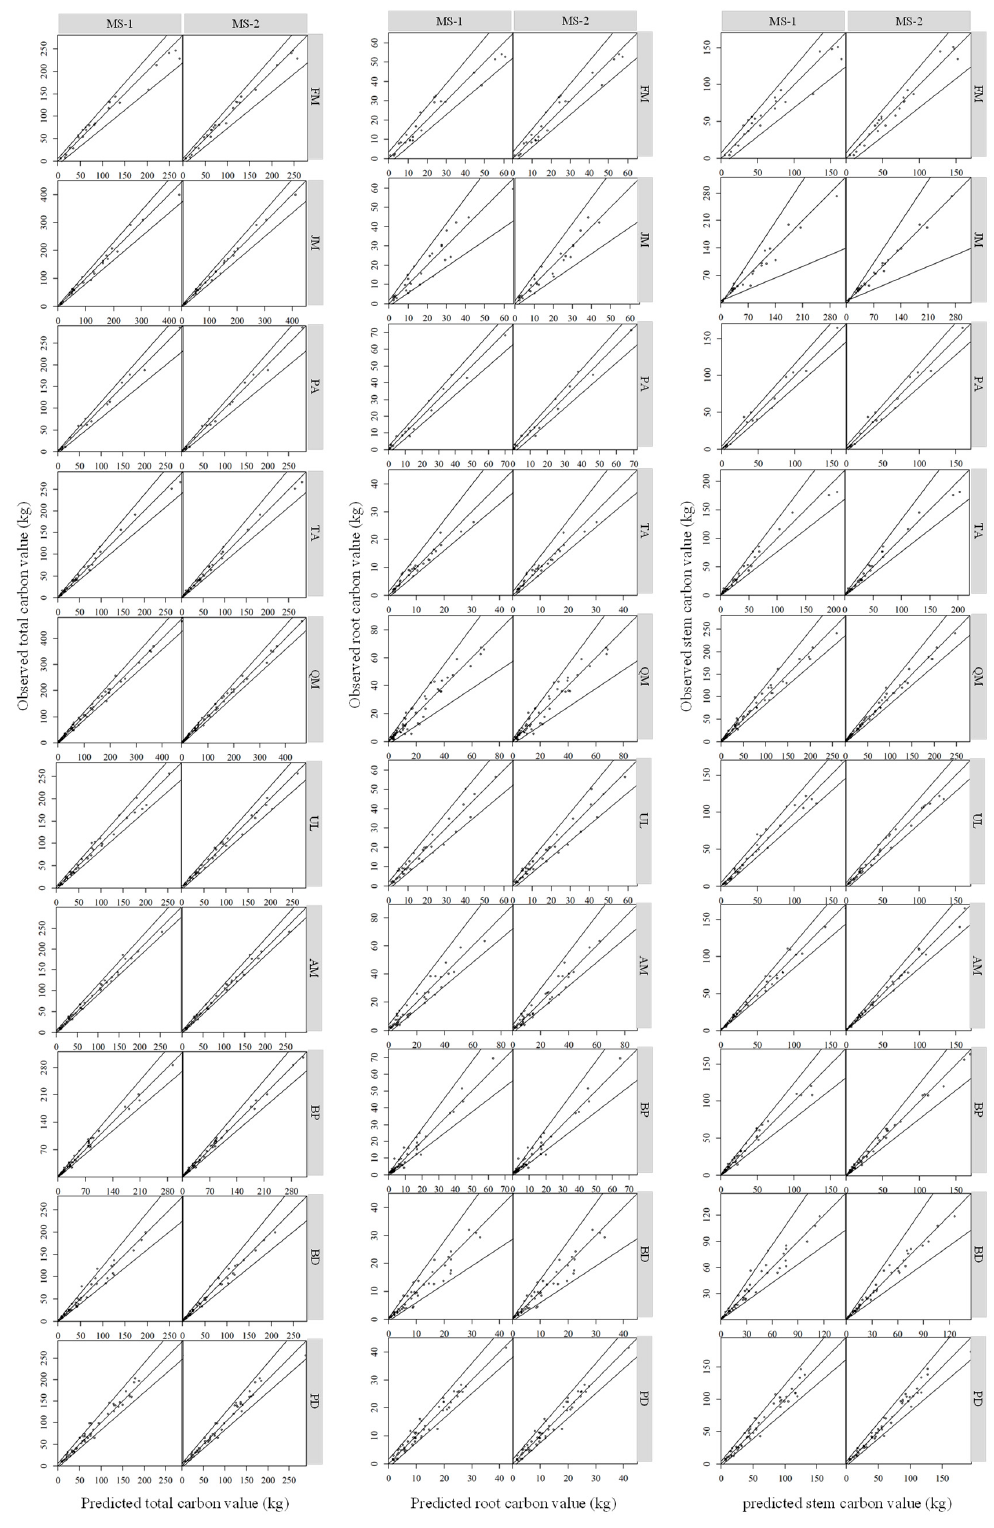
Figure 4. Multi-panel display of observed total, stem, and root carbon for 10 tree species plotted against their predicted values from MS-1 and MS-2. The diagonal line of unity is shown together with the 90% upper and lower confidence limits of prediction error in each panel. FM: Fraxinus manshuric ; JM: Juglans mandshurica ; PA: Phellodendron amurense ; QM: Quercus mongolica ; TA: Tilia amurensis ; UL: Ulmus laciniata ; AM: Acer mono ; BP: Betula platyphylla ; BD: Betula davuria ; PD: Populus davidiana .